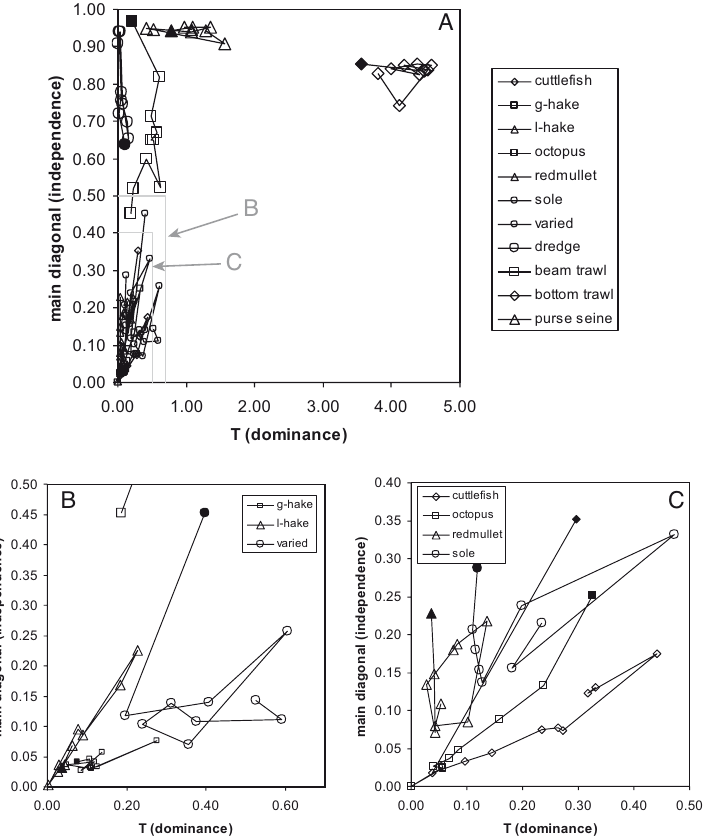
F ig . 5. – Independence vs dominance plot of 11F Catalonia, showing the annual trends. The first year of the series (2000) is indicated by a solid dot. In A the whole plot to note the positions of bottom trawl, purse seine, beam trawl and dredge is presented. The other seven fleets are presented in plots B and C to discriminate